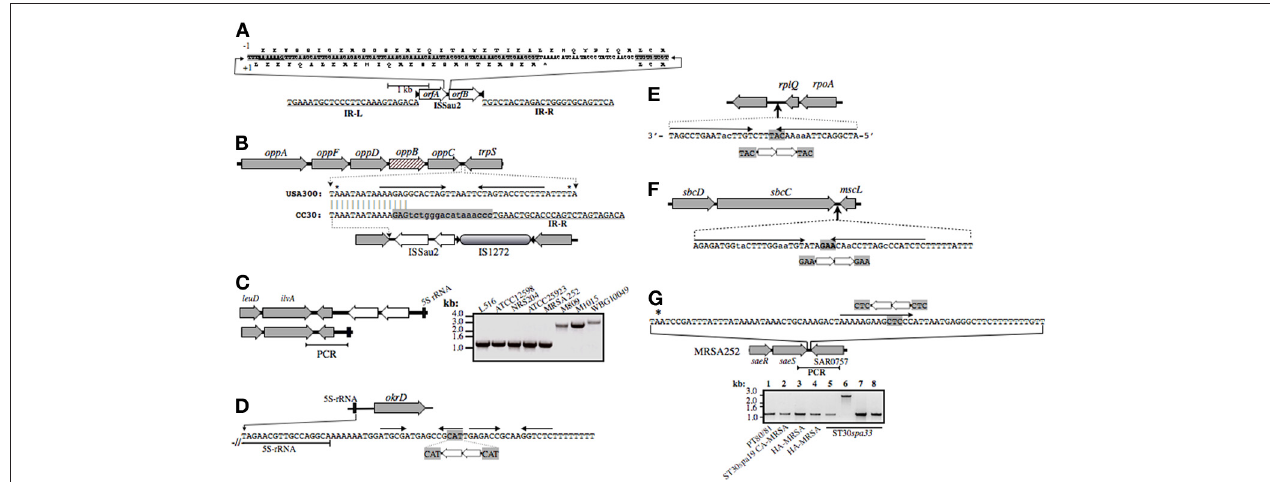
FIGURE 3 | Illustration of ISSau2 (A) and its insertion sites (B–G) in CC30. ISSau2 is comprised of orfA and orfB (A) , flanked by 39 nt inverted repeats IR-L and IR-R, with terminal 5 (cid:4) -TG and 3 (cid:4) -CA dinucleotides (A) . The sequence above the illustration spans the 3 (cid:4) -end of orfA and 5 (cid:4) -end of orfB . The + 1 translation of orfA , terminating at a stop codon, is shown below the sequence. Above the sequence is a translation that would result from a − 1 frame-shift within AAAAAAG . The − 1 translation from this point onwards continues throug to the end of orfB , and would produce a single 1569 nt trans-frame protein. (B) Illustration of oppAFBDC and trpS genome segment of non-CC30 strain USA300. Beneath this is shown the oppC-trpS intergenic sequence of USA300, aligned to that MRSA 252. Asterisks above the USA300 sequence indicate stop codons of oppC and trpS . Convergent arrows indicate inverted repeats, likely comprising a rho -independent transcription terminator stem-loop structure. In all CC30 strains, the left arm of the stem is disrupted by a flanking repeat of IS1272 (shaded gray), which in turn is disrupted by ISSau2. In MRSA 252, oppB (cross-hatched) has an in-frame internal deletion that is unique to the EMRSA-16 lineage. (C) ISSau2 insertion in the genome of S. aureus TCH60 (top), which is ST30 spa19 CA-MRSA (Clade 2), and corresponding segment of MRSA 252 (bottom). PCR with primers spanning the 3 (cid:4) -end of the 5S rRNA and flanking ilvA (right panel) reveal that this insertion is in Clade 1 strains (M809, M1015) and